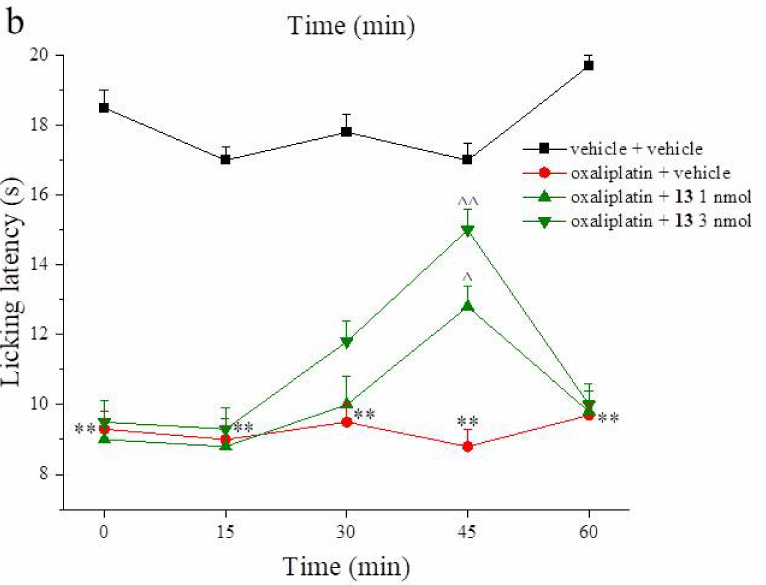
Figure 5. Pain-relieving effect of ( a ) 4 and ( b ) 13 on oxaliplatin-induced thermal allodynia in mice. Cold plate test. Oxaliplatin (2.4 mg kg − 1 ) was dissolved in 5% glucose solution and intraperitoneal (i.p.) administered for 5 consecutive days every week for 14 days. Starting from day 14, compounds were dissolved in saline solution and intrathecally administered at the doses of 1 nmol/mouse and 3 nmol/mouse in a final volume of 5 µ L. Pain-related behavior (i.e., lifting and licking of the hind paw) was observed and the time (s) of the first sign was recorded. ** p < 0.01 vs. vehicle + vehicle treated animals; ˆ p < 0.05 and ˆˆ p < 0.01 vs. oxaliplatin + vehicle treated animals. Each value represents the mean ± S.E.M. of 10 mice performed in two different experimental sets (10 mice treated with oxaliplatin and 10 control mice). The analysis of variance was performed by one-way ANOVA. A Bonferroni’s significant difference procedure was used as post hoc